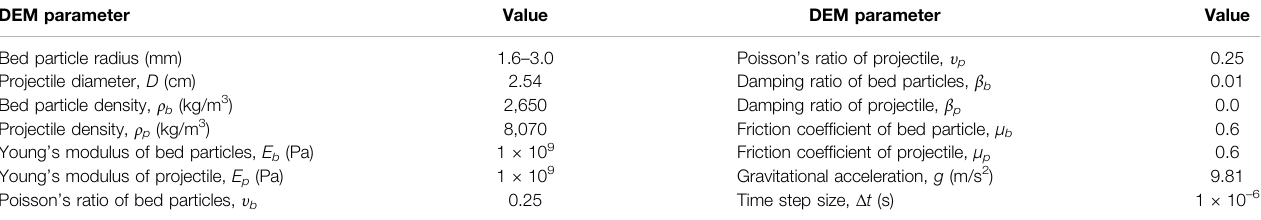
TABLE 1 | Input parameters used in the DEM simulations.